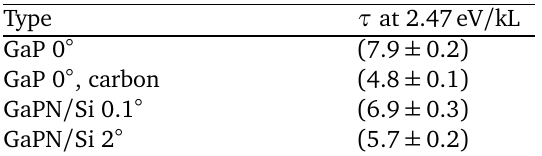
Figure 8: AFM image (tapping mode) of a 300 nm-thick GaPN sample on 0.1 ◦ offcut Si(100) with 20 nm intermediate GaP buffer. Table 1: Lifetimes τ of different P-rich GaP and V-rich GaP(N) / Si(100)